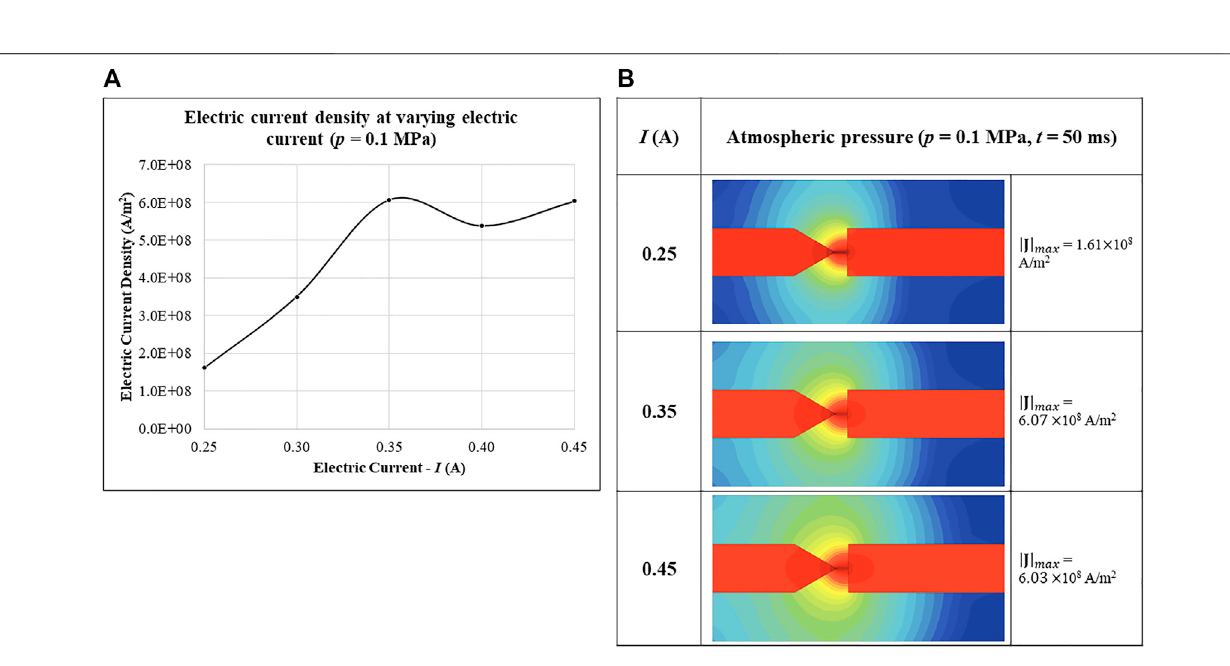
Frontiers in Physics |